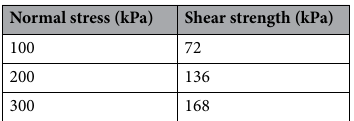
Table 1. The shear strength under different normal stresses.